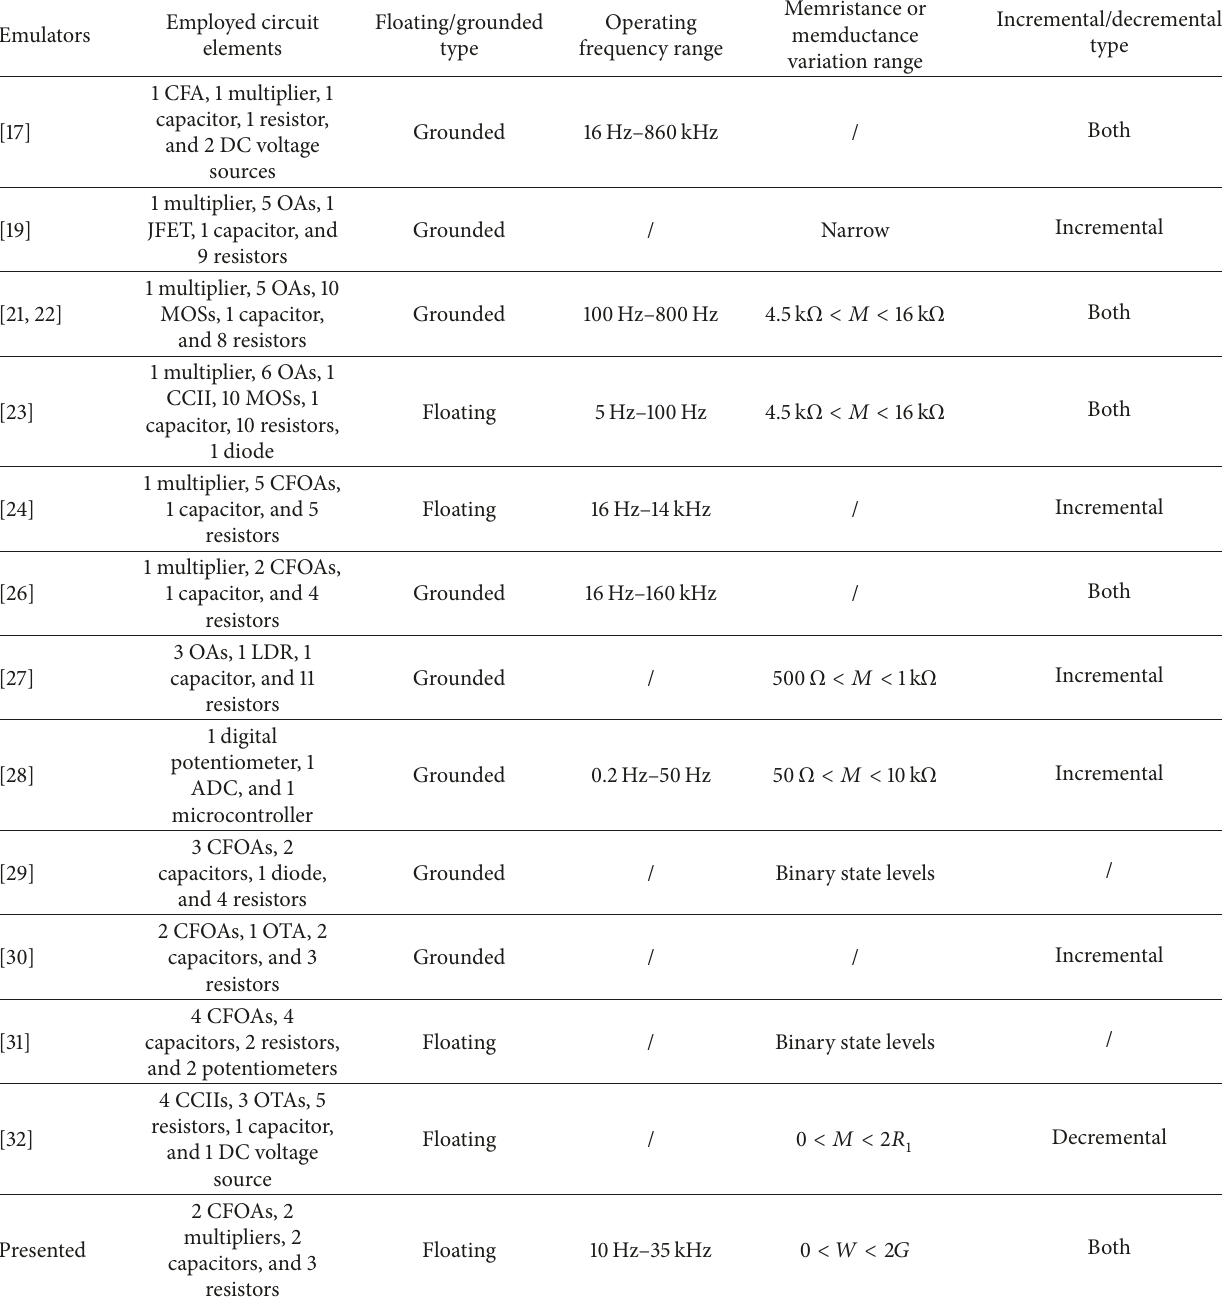
Table 2: Comparison of presented emulator with other published